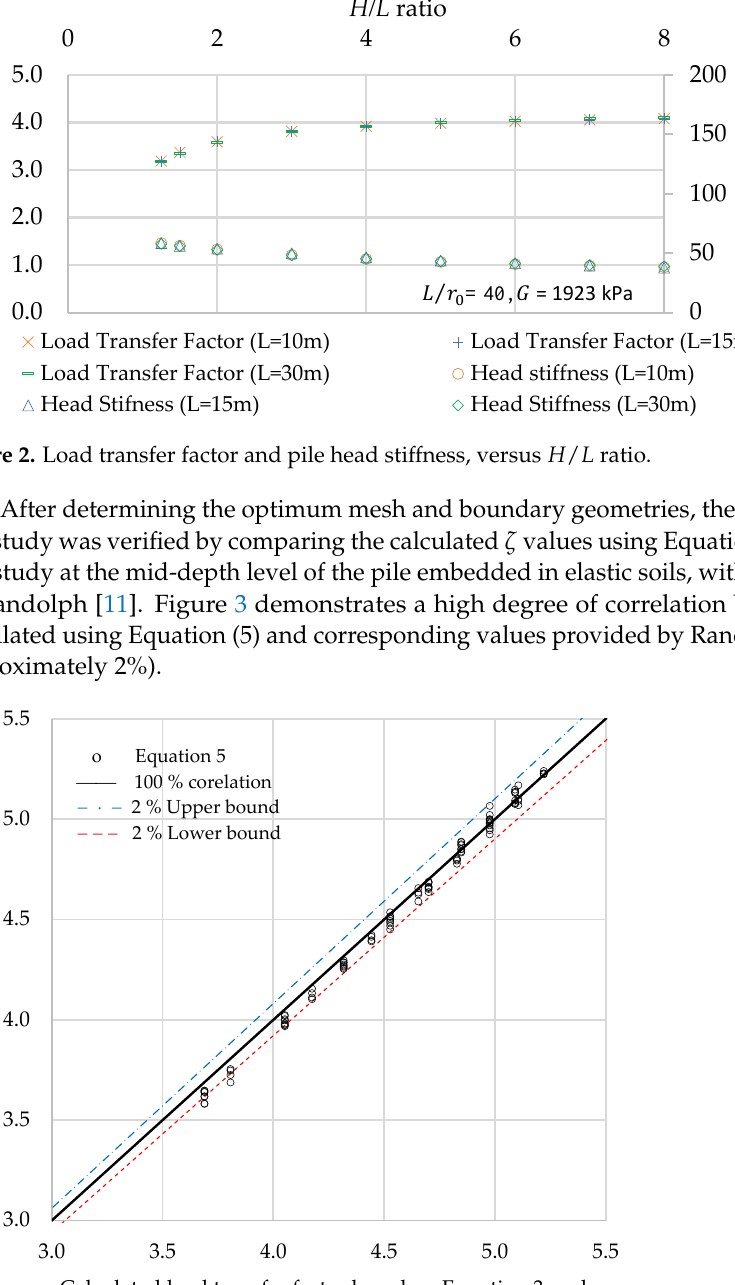
Figure 3. Load-transfer factors (  ) from PLAXIS 2D versus equivalent  factors from Randolph [11], for about 100 cases ( 𝐿 = 10–25 m, 𝐿/𝑟 0 = 20–90, υ 𝑠 = 0.2–0.3, 𝐺 = 3.8–7.7 GPa).